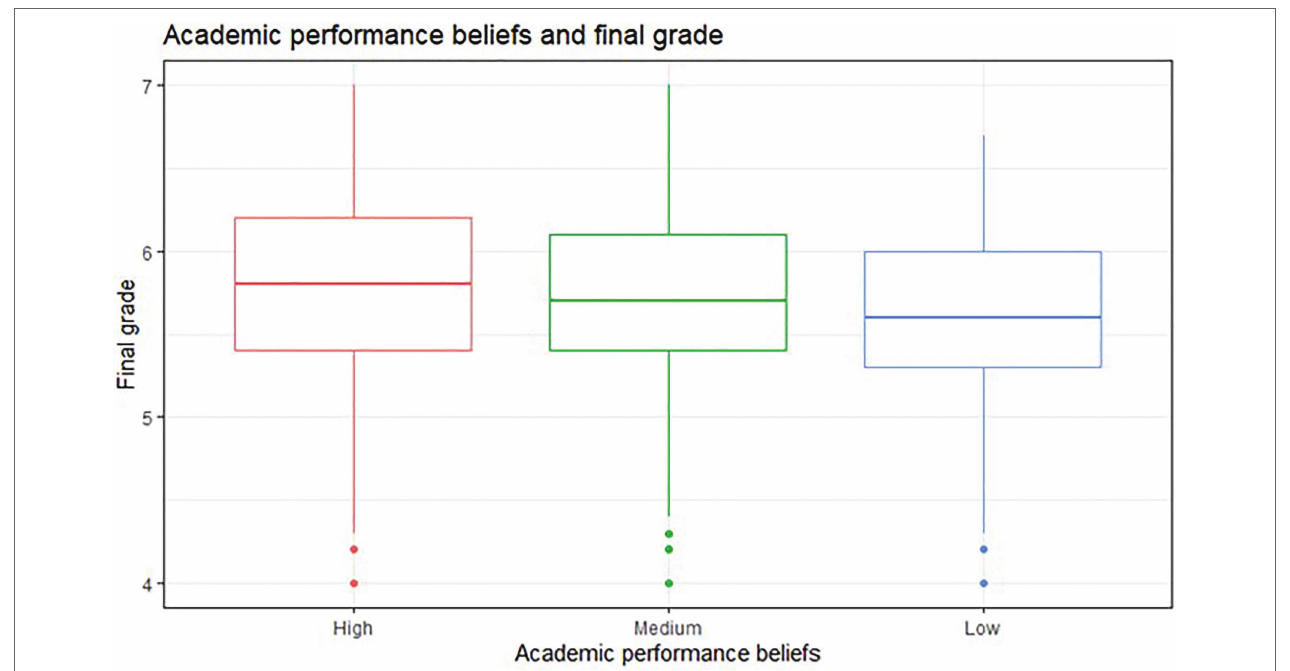
FIGURE 3 | Description of academic performance beliefs (T1) and final grade (T2) from STEM students’ during the ERT